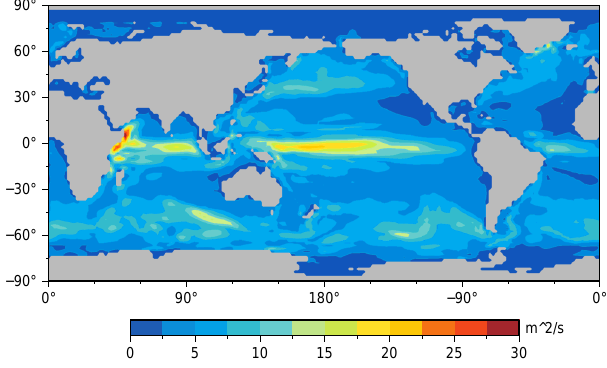
Figure 8. Standard deviation of depth-integrated ocean flow veloc- ities over the upper